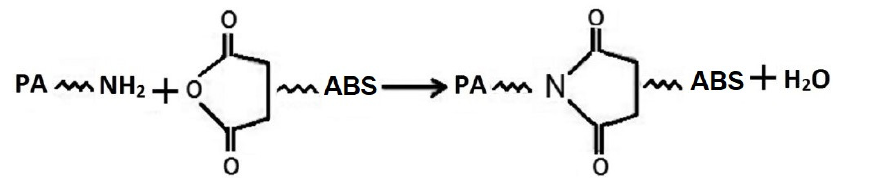
Figure 3. Reaction of maleic anhydride group of ABS-MA with PA6 amine group forming imide (adapted from [18]).